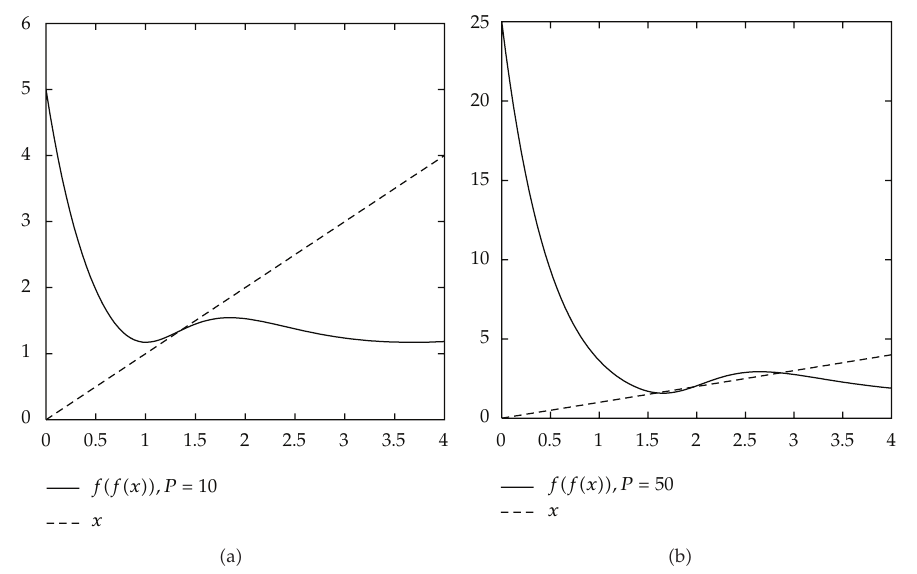
Figure 3: The unique equilibrium point is stable if the equation has no two-cycle, or the curve y (cid:8) f (cid:4) f (cid:4) x (cid:5)(cid:5) intersects y (cid:8) x only once. Here f (cid:4) x (cid:5) is defined in (cid:4) 3.1 (cid:5) , α (cid:8) 0 . 5, q (cid:8) 2, where p (cid:8) 10 (cid:4) a (cid:5) and p (cid:8) 50 (cid:4) b (cid:5) . For p (cid:8) 10 there is one intersection point (cid:4) stability (cid:5) while for p (cid:8) 50 there are three intersection points (cid:4) the two-cycle is stable rather than the positive equilibrium (cid:5)